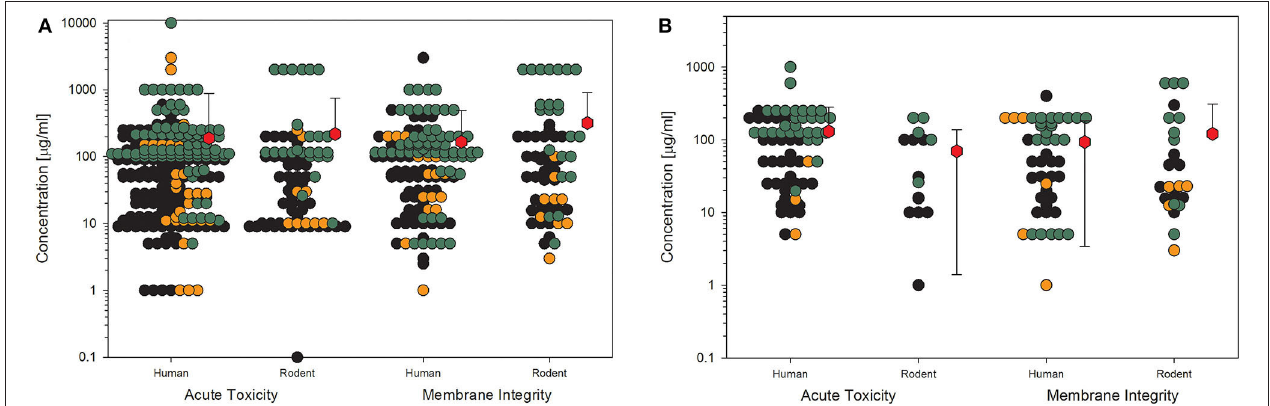
FIGURE 6 | Comparison of human and rodent cell lines in terms of their sensitivity to amorphous silica treatment. Datasets on the key events “acute toxicity” and “membrane integrity” are shown. For this comparison, only data for particles with primary sizes below 100nm were included. Mean values are calculated from each dot cloud (red hexagons). (A) All available datasets; (B) datasets from studies with high-quality scores of 0.8 or 1. Details are as those shown in Figure 2 .